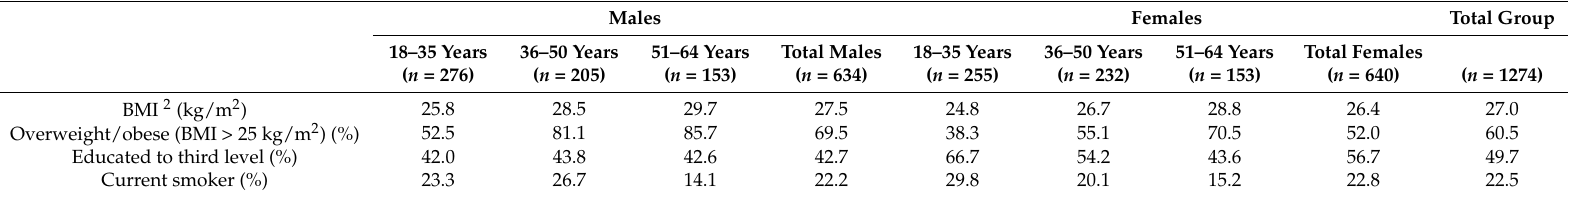
Table 1. Baseline demographic and lifestyle data for study sample of adults aged 18–64 years ( n = 1274), Republic of Ireland 1 .